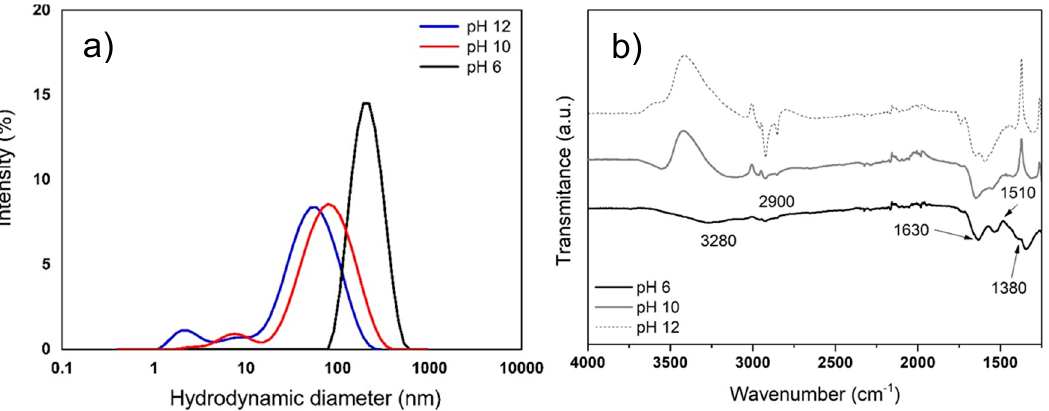
Figure 4. Characterization of AgNPs synthesized using aqueous extracts of R. aculeata cell suspen- sion culture at different pHs. ( a ) DLS analysis of the average size of AgNPs; ( b ) FTIR spectra of synthesized AgNPs.